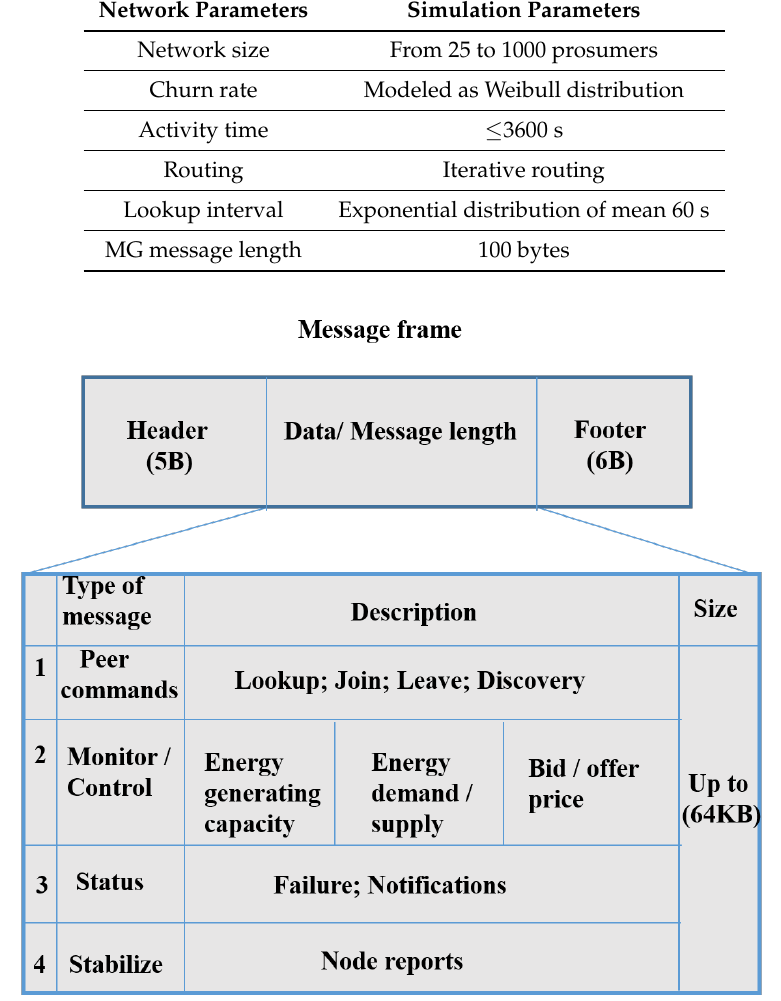
Figure 2. Communication packet frame structure of micro-grid (adapted from